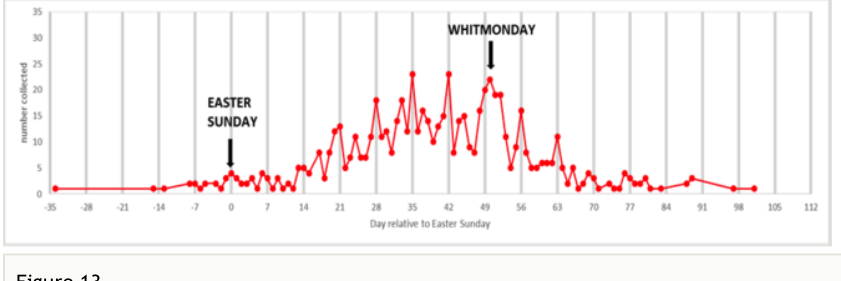
The graph indicates the when during the year specimens of the Orange Tip ( Anthocharis indicates the number of specimens